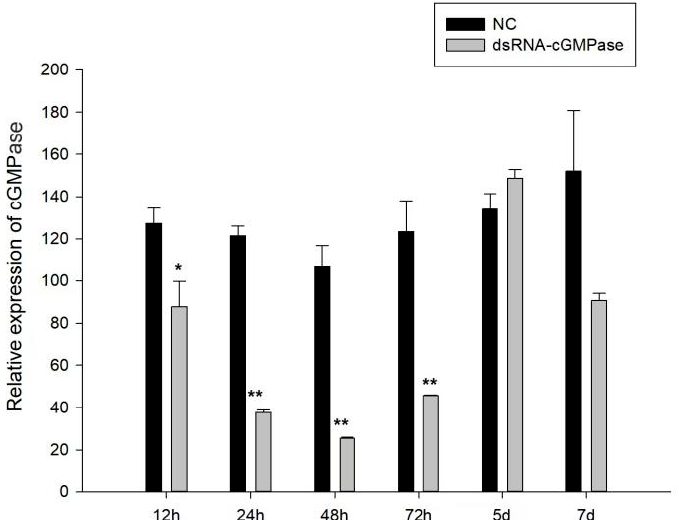
Figure 8. Screening dsRNA interference toward cGMPase time points during the S. constricta growth period. The horizontal axis represents different time points after injection. A single asterisk means there is a signifificant difference (* p < 0.05), and double asterisks mean a highly significant difference (** p < 0.01).